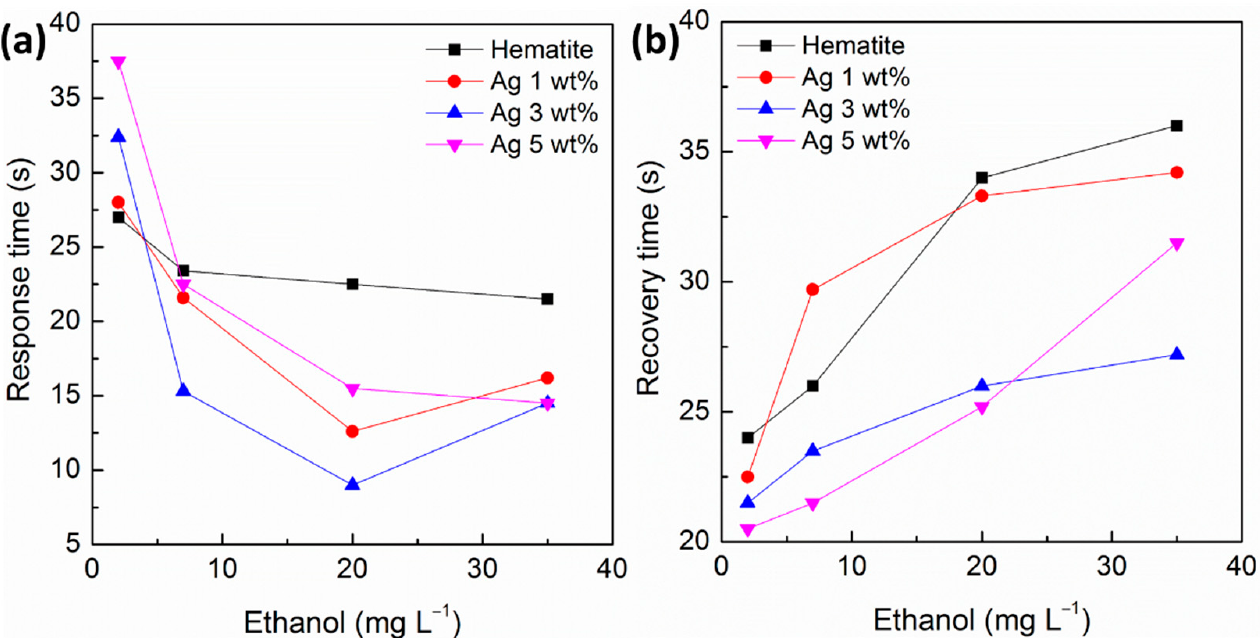
Figure 5. Effect of Ag loading on the sensor sensitivity to ethanol: ( a ) Comparison of the sensors signal when exposed to 35 mg L − 1 of ethanol vapor at 25 °C, ( b ) signal response as a function of ethanol vapor concentration. Composite nanosensors: ( ) Pristine hematite, ( ) α -Fe 2 O 3 /Ag 1.0 wt%, ( ) α -Fe 2 O 3 /Ag 3.0 wt%, and ( ) α -Fe 2 O 3 /Ag 5.0 wt%.